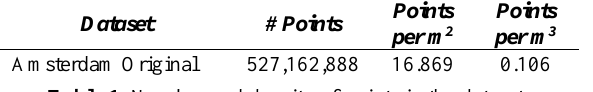
Table 1. Number and density of points in the